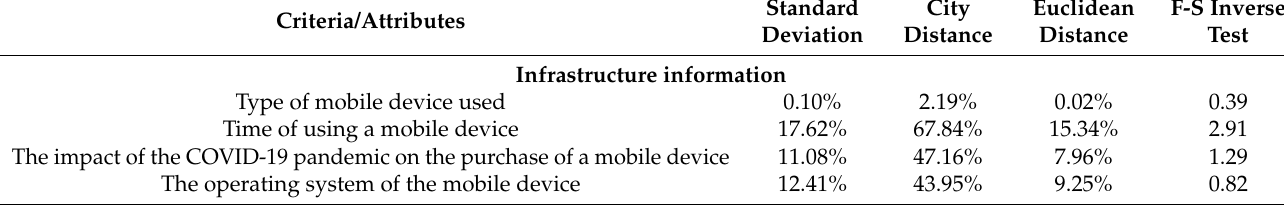
Table 8. Indicators of differences between the criteria (attributes) used to assess mobile payments in Poland and Turkey in 2021; source: own